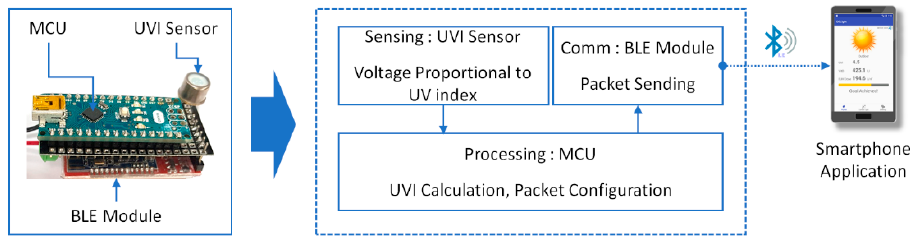
Figure 3. Block diagram and process flow of Internet of Things (IoT) ultraviolet measuring device.